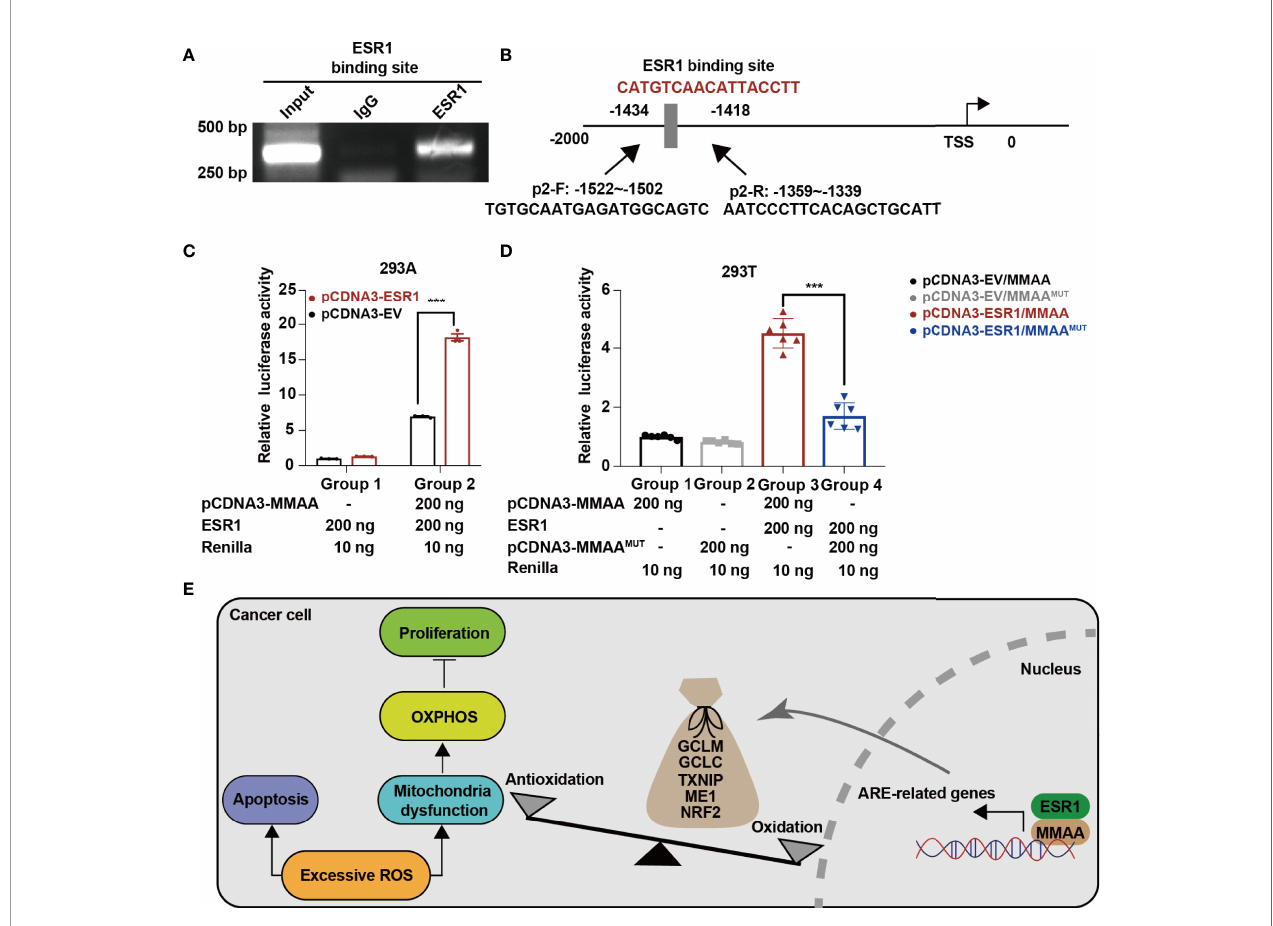
FIGURE 7 | ESR1 regulates the metabolism of cobalamin-associated A (MMAA)/antioxidant response element activation in HCC. (A) ESR1 occupied the binding site on the MMAA promoter region as revealed by ChIP assays. (B) Position of the potential sequence in the MMAA promoter. (C, D) ESR1 increased the luciferase activity of the MMAA promoter in 293A and 293T cells. (E) A working model illustrating the antioncogenic function of MMAA in HCC. *** P < 0.001; three biological repeats per